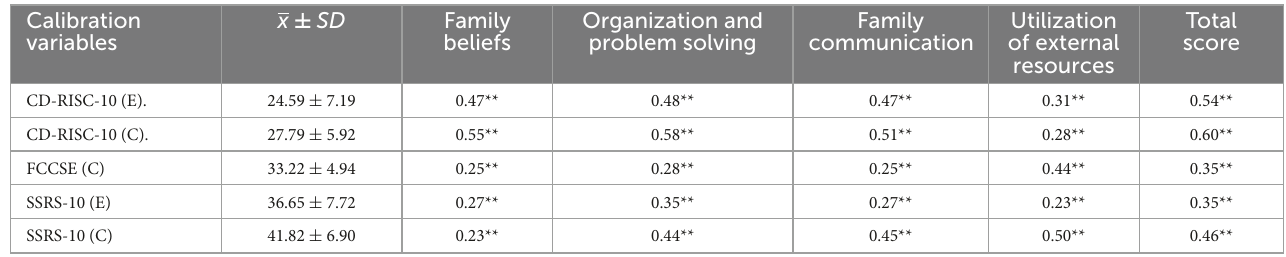
x ± SD Family Organization and beliefs problem solving